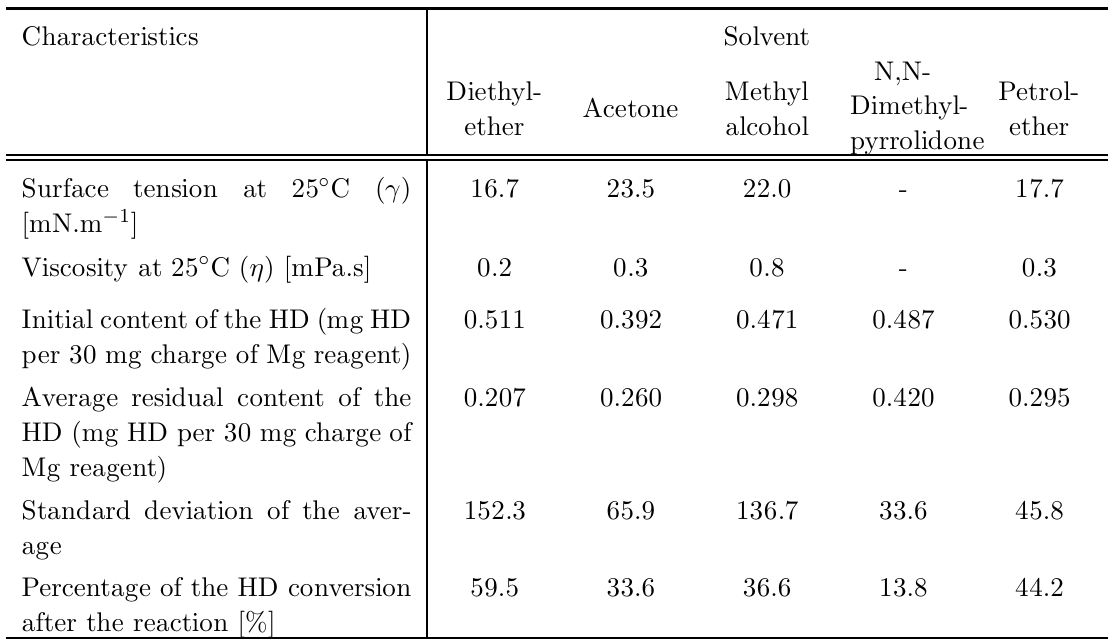
Table 3 Residual content of the HD after reaction on the magnesium sample Mg 15/1/380 (reaction time 2 h, temperature 25 ¯ C, charge of the reagent 30 mg, the HD dissolved in 0,02ml of